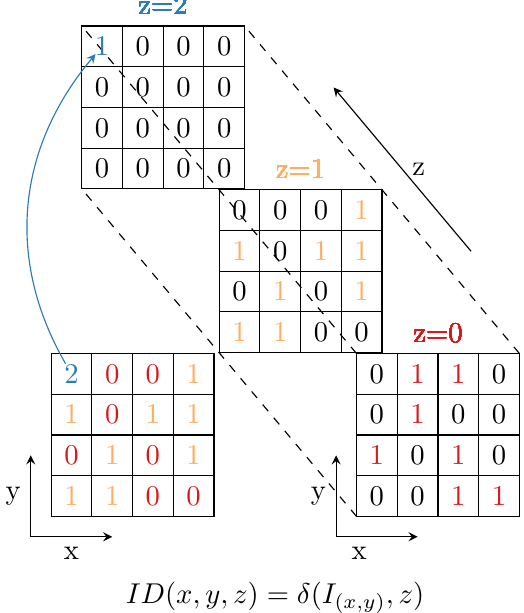
Figure 1. Indicator array generation: z coordinates are calculated from the pixel value of the 2D